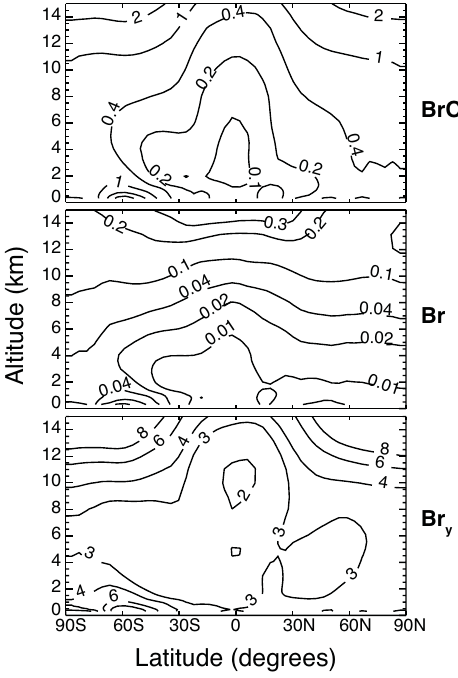
Fig. 4. Zonal annual mean concentrations (pmolmol − 1 ) of BrO, Br, and Br y in GEOS-Chem. 4 Comparison to satellite observations of tropospheric BrO Figure 5 compares simulated BrO tropospheric columns to a GOME-2 satellite data set retrieved by Theys et al. (2011) with monthly resolution for 2007 and for six latitudinal bands. Theys et al. (2011) fitted total slant columns of BrO to the solar backscattered radiation spectra. They then re- moved the stratospheric contribution by using correlations of stratospheric BrO with ozone and NO 2 from the BASCOE 3D-CTM (Theys et al., 2009) and applying these correla- tions to the local GOME-2 observations of ozone and strato- spheric NO 2 columns. They converted the tropospheric slant columns to vertical columns with an air mass factor assum- ing a Gaussian-shaped vertical distribution of BrO peaking at 6 km altitude. The grey shading in Fig. 5 indicates the total observational error estimated by Theys et al. (2011), including contributions from the air mass factor, surface albedo, cloud fractions, stratospheric BrO column removal, and cloud top heights. The GOME-2 data are for ∼ 09:30 local time (LT) and we sample GEOS-Chem at 09:00–11:00 LT for comparison. GEOS-Chem data in Fig. 5 include both the actual tropo- spheric vertical columns (red) and the columns corrected for the Theys et al. (2011) air mass factors using their tabulated scattering weights including for partly cloudy scenes.